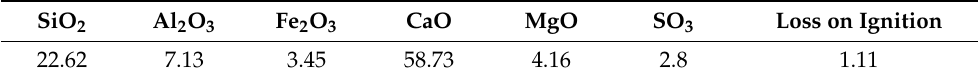
Table 1. Chemical compositions of